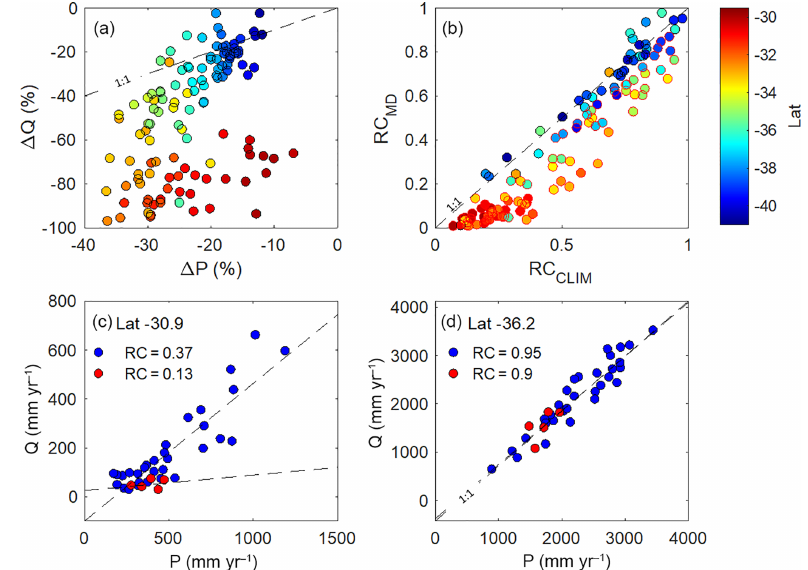
Figure 10. (a) Scatter plot between the meteorological and hydrological MD-standardized deficits (DP and DQ, respectively) in 119 basins along central Chile. For both variables the deficit was calculated as the difference between the MD-average (2010–2015) values minus the long-term mean (LTM, 1979–2009) and then divided by the LTM. (b) Scatter plot of the annual runoff coefficient (RC) calculated for the historical period (1979–2009) and the MD period (2010–2015) in 119 basins along central Chile. The basins that experienced a significant change in RC are marked with red borders. In panels (a) and (b) the colors of the circles indicate the latitude of the basin outlet. (c) Scatter plot between the area-averaged annual mean precipitation and the basin runoff (annual mean river flow divided by the basin area) for Rio Grande at the Cuyano basin (30.9 ◦ S). (d) As (c) but for Longavi at the Quiriquina basin (36.2 ◦ S). In panels (c) and (d) the rainfall–runoff values during the years forming the MD are indicated in red. In panels (a) , (b) and (d) the dashed line is the 1 : 1 line. In panel (c) the dashed lines are regression